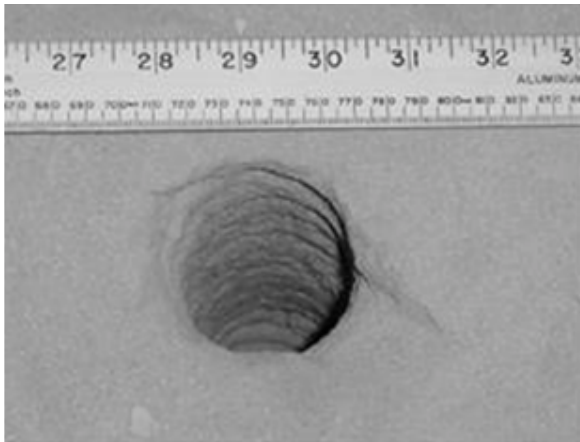
Figure 4. 3.5 mm Atypical pores in huangshatite [25].